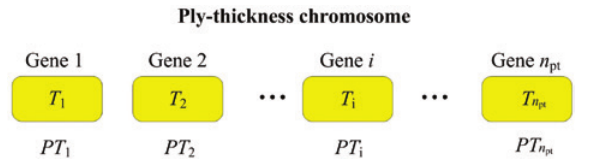
Figure 5: The ply-ranking